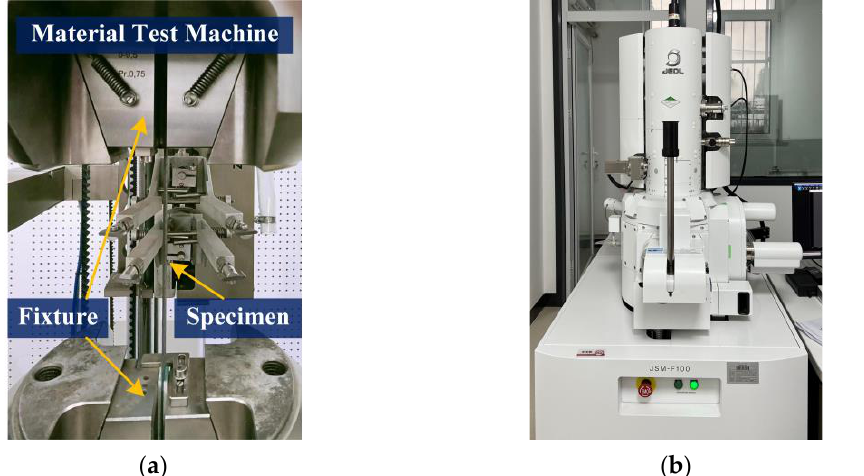
Figure 4. Devices for tests on the UD composite specimens: ( a ) setup for tensile test; ( b ) setup for SEM test.